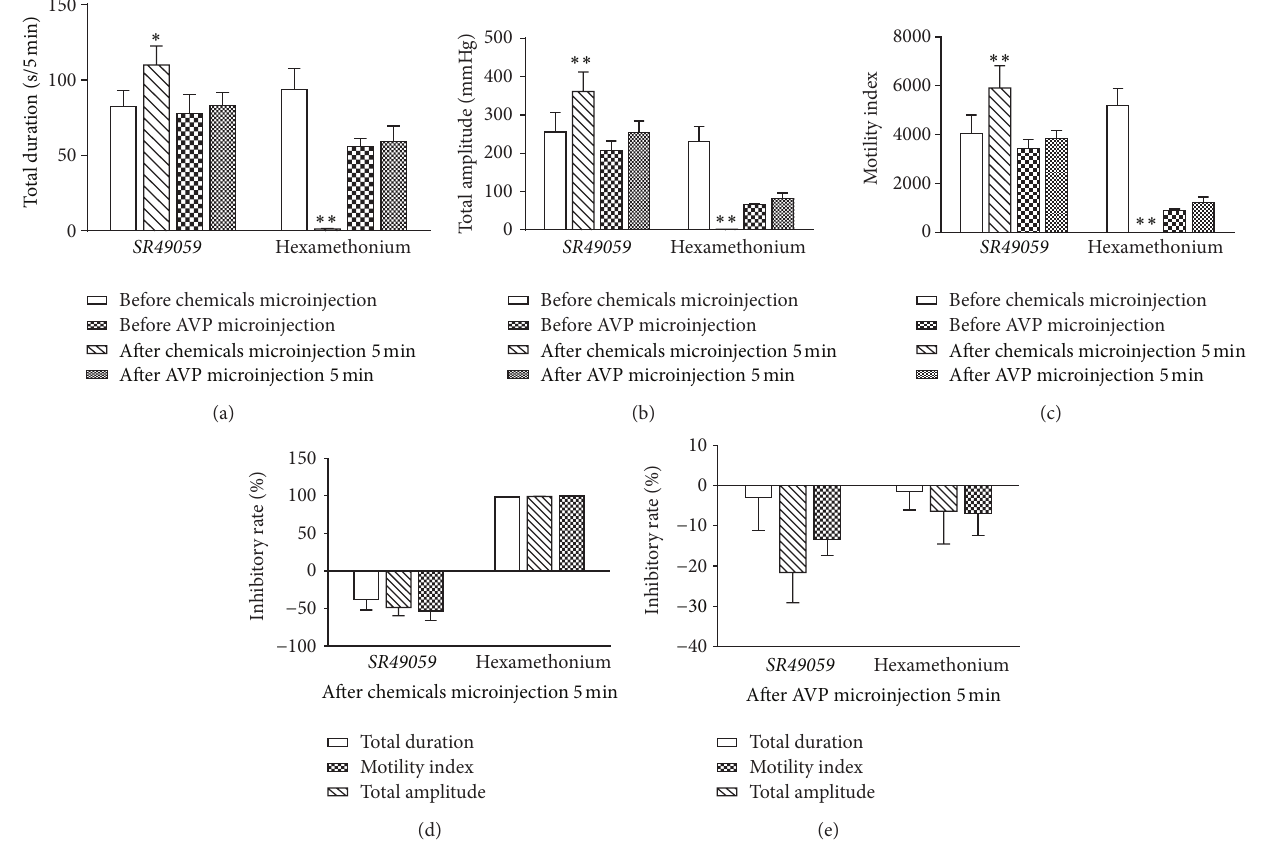
Figure 5: Effects of AVP (180pmol) on gastric motility with pretreatment of SR49059 (320 pmol) or Hexamethonium (8 𝜇 mol). Mean data of total duration (a) and total amplitude (b) and motility index (c) before microinjection and after microinjection 0–5 min, 5–10min, and 10–15min. Average inhibitory rate of total duration, total amplitude, and motility index before and after microinjection of SR49059 (d) and Hexamethonium (e). ∗ 𝑃 < 0.05 and ∗∗ 𝑃 < 0.01 , versus before